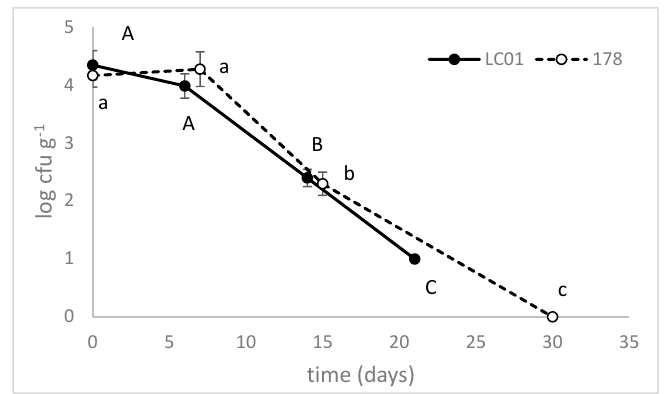
Figure 4. Enterobacteria counts, during the ripening of traditional sausages inoculated with Lb. casei LC01 or Lb. plantarum 178. Mean ± standard deviation. The letters indicate statistically significant differences throughout time (one-way ANOVA and Tukey’s test, p < 0.05): small letters, sausages inoculated with Lb. plantarum 178; capital letters, LC01.